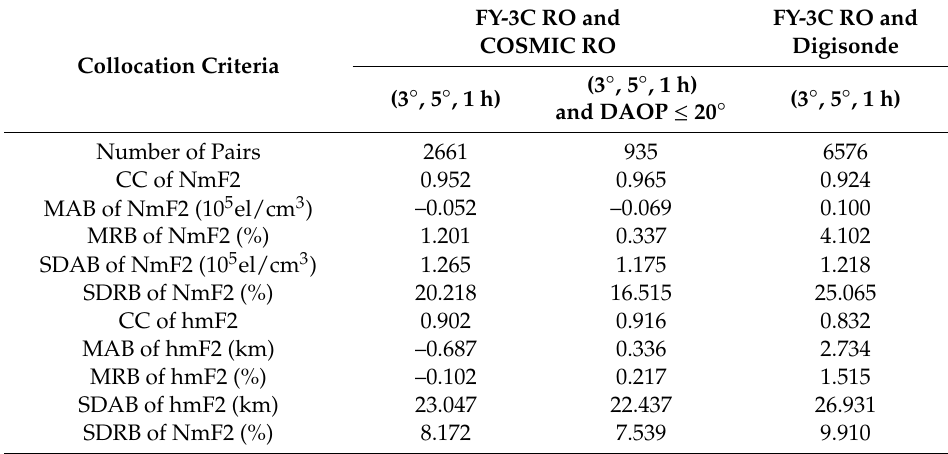
The statistical parameters for the comparisons of ICPs derived by FY-3C RO and other